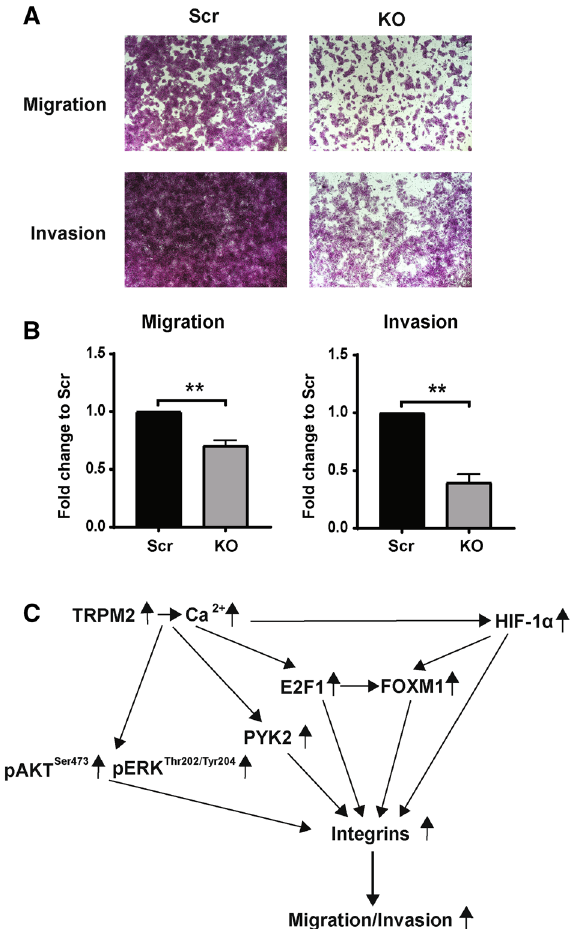
Figure 8. Migration and Invasion in neuroblastoma cells. ( A ), ( B ) Migration and invasion assays were performed with SK-N-AS KO cells (KO) and scrambled control cells (Scr-V) as described in Methods. Representative pictures from Boyden chambers of one migration and invasion experiment are shown in ( A ). Pictures from two additional migration and invasion experiments with SK-N-AS cells are shown in Supplementary Fig. 8C. ( B ) Densitometry analysis of migration and invasion density of scrambled and TRPM2 KO SK-N-AS cells. Three migration experiments and three invasion experiments were performed. The mean from each experiment was quantitated comparing KO to scrambled cells, and used to calculate mean + S.E.M. of all three. Statistical difference of SK-N-AS KO compared to scrambled control was analyzed by two-tailed T-test, ** p < 0.003. ( C ) Schema of TRPM2 modulation of migration/invasion in neuroblastoma. Higher levels of TRPM2 enhance migration and invasion. In SH-SY5Y cells, increased migration and invasion were associated with increased expression of HIF-1α, E2F1, and FOXM1 transcription factors and downstream integrin targets, and activation of Akt and